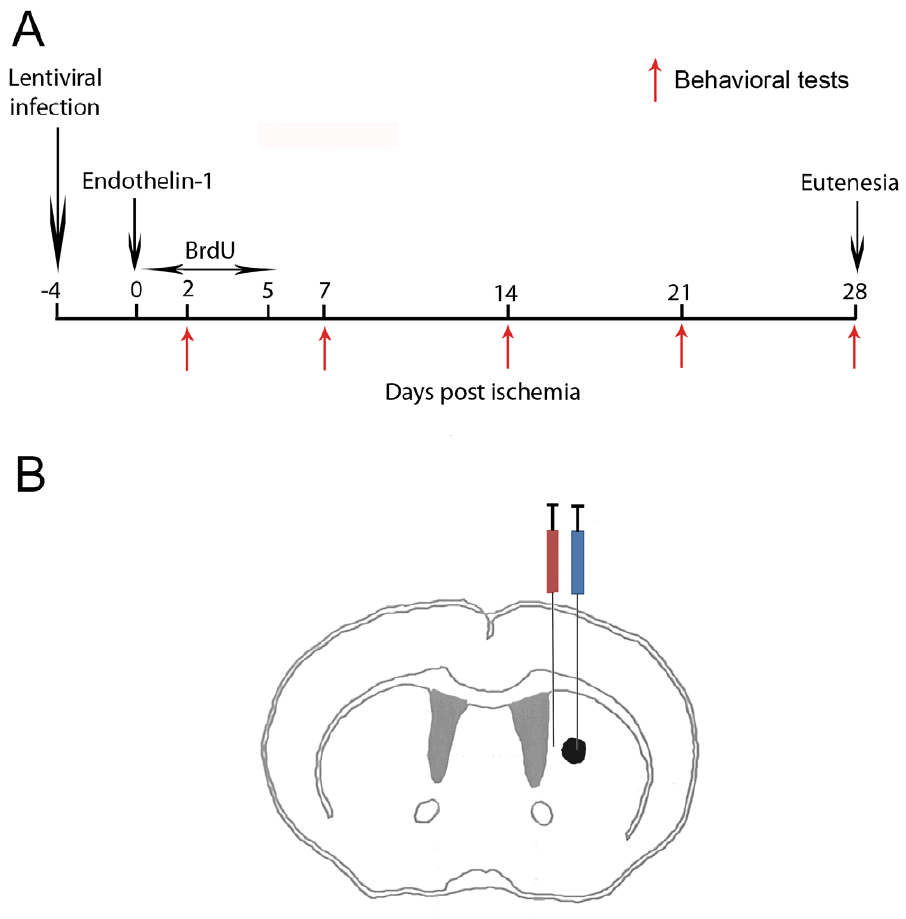
Figure 1. Schematic representation of the experimental design. A. Experimental protocol. B. Diagram of the brain section. Lentiviral vector was injected into either the striatum (blue syringe) or SVZ (red syringe). The ischemic area in the striatum is circled in black.